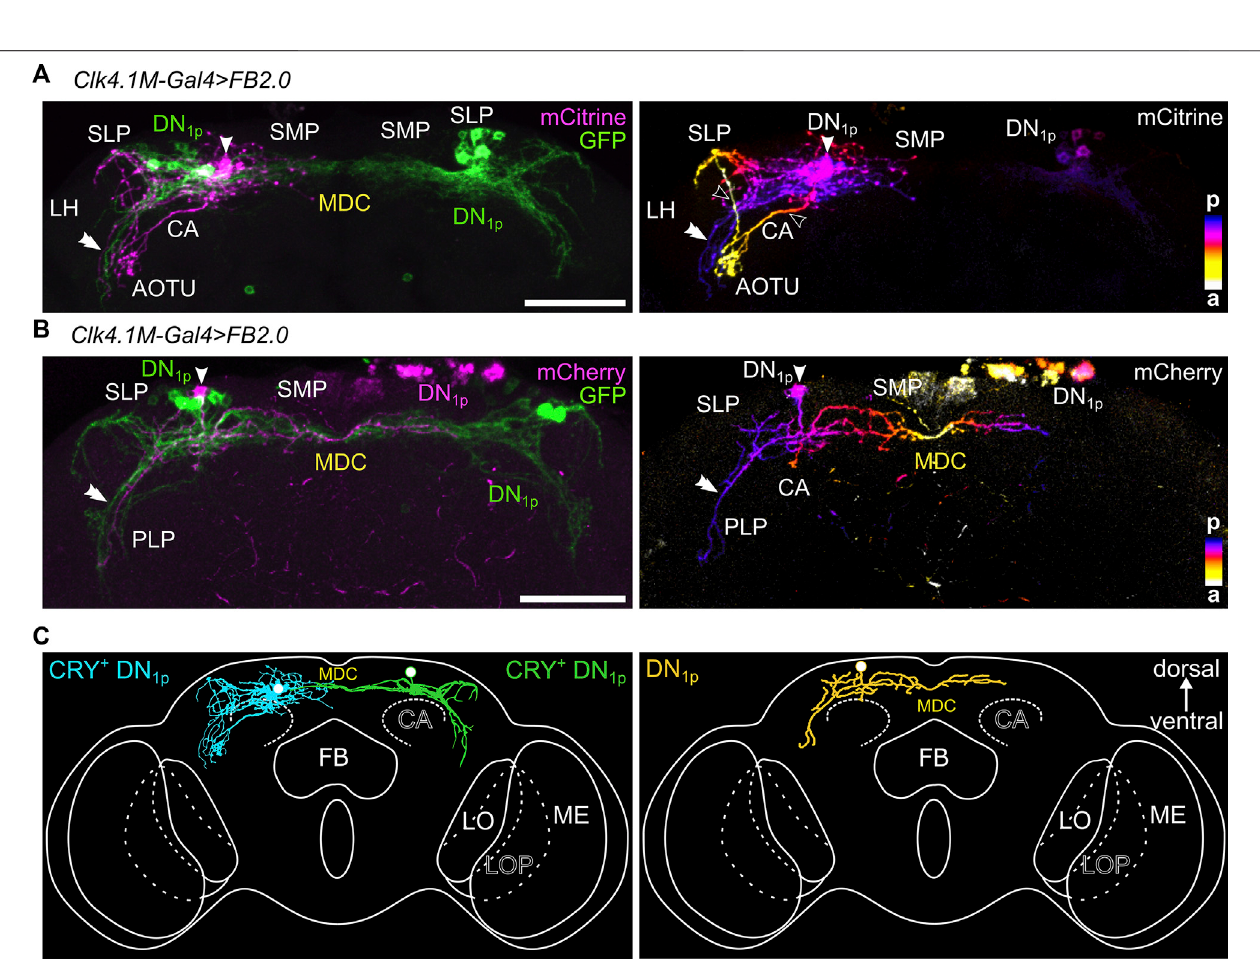
FIGURE5| Differentmorphological subtypes withinthe DN 1p sasrevealed byFlybowstaining. (A , B) Clk4.1M-GAL4 driven Flybow-reporter expression indifferent DN 1p s. The left panels show the originalFlybow-reporter expression in which an individuallylabeled neuron (magenta, arrowhead) expresses mCitrine ormCherry, while several other DN 1p s express the default GFP reporter (green). The right panels depict the single DN 1p s that are marked in magenta in the left panels with color-coded depth information (anterior (a) in yellow colors, posterior (p) in blue colors as shown in the color code bars in the right bottom of each fi gure). (A) mCitrine marks a singleneuronwitharborizationsinthesuperiorlateralprotocerebrum(SLP).Two fi bers(openarrowheads)runanteriortothelateralanterioroptictubercle(AOTU),where they arborize prominently. Another fi ber (double arrowhead) remains in the posterior brain and runs ventrally following the s-LN v projections. (B) Single DN 1p expressing mCherry (magenta) among four other GFP expressing DN 1p s. The single DN 1p has a prominent fi ber following the path of the s-LN v s in the ipsilateral posterior lateral protocerebrum (PLP)andcrossesthedorsoventralmidlineofthebrainthroughthemiddledorsalcommissure(MDC).NoarborizationsintheanteriorSLParevisible. (C) Schematic depiction of the three DN 1p subtypes identi fi ed by Flybow. SMP, superior medial protocerebrum; LH, lateral horn; PLP, posterior lateral protocerebrum; ME, medulla; LO, lobula; LOP, lobula plate; FB, fan-shaped body. Scale bars represent 50 μ m.